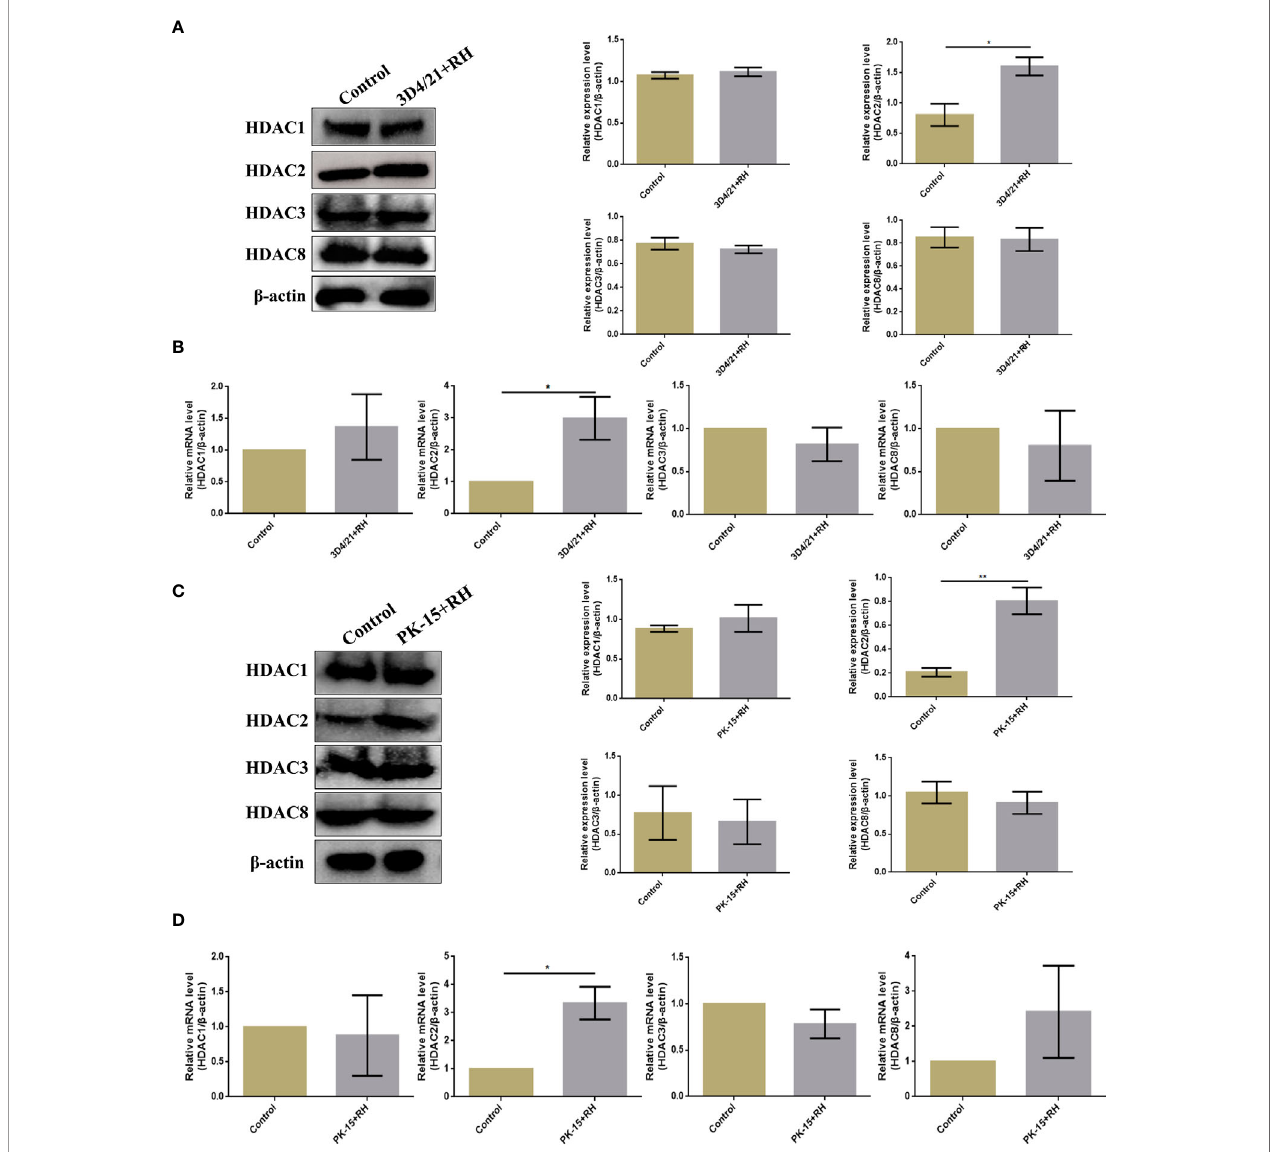
FIGURE 5 | T. gondii leads to a decrease in HDAC2 in porcine alveolar macrophages and PK-15 cells. (A) Western blot analysis of the expression levels of class I HDACs in 3D4/21+RH and control cells. (B) RT-PCR analysis of the expression levels of class I HDACs in 3D4/21+RH and control cells. (C) Western blot analysis of the expression levels of class I HDACs in PK-15+RH and control cells. (D) RT-PCR analysis of the expression levels of class I HDACs in PK-15+RH and control cells. The data are presented as the mean ± SEM of three independent experiments. *p < 0.05, **p < 0.01, Student ’ s t